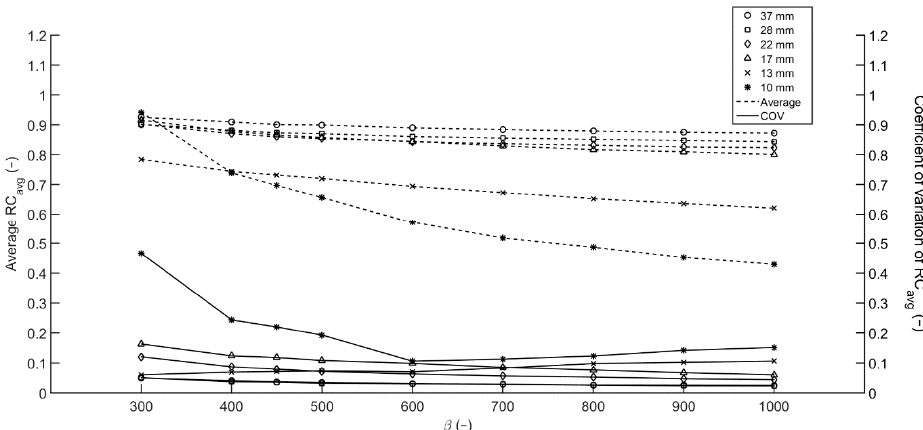
Figure 4. Averaged RC avg and COV from the Image Quality phantom. Averaged RC avg over 6 reconstructions with varying acquisition times per bed position (1, 2 and 5 min) and T/B ratios (10:1 and 20:1).